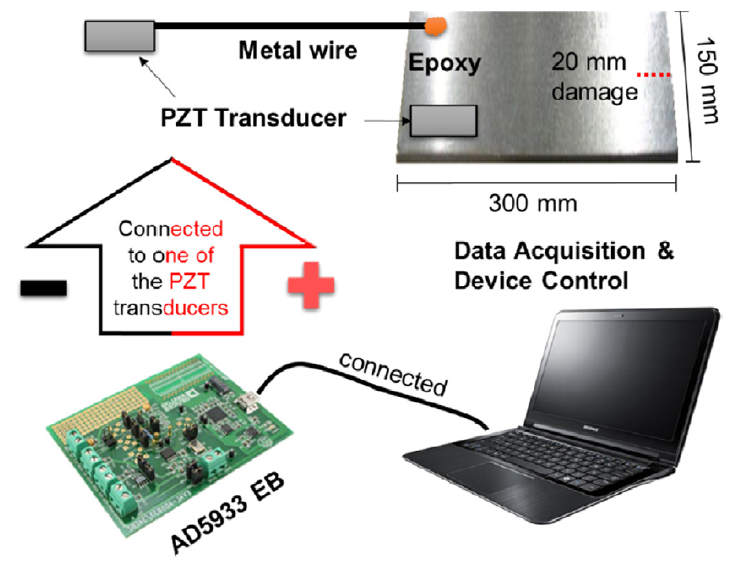
Figure 57. Using a metal wire as a bridge between the PZT and the epoxy coating of a pipeline for EMI measurement. Reprinted from Journal of Sound and Vibration, Volume 383, Na, W.S.;